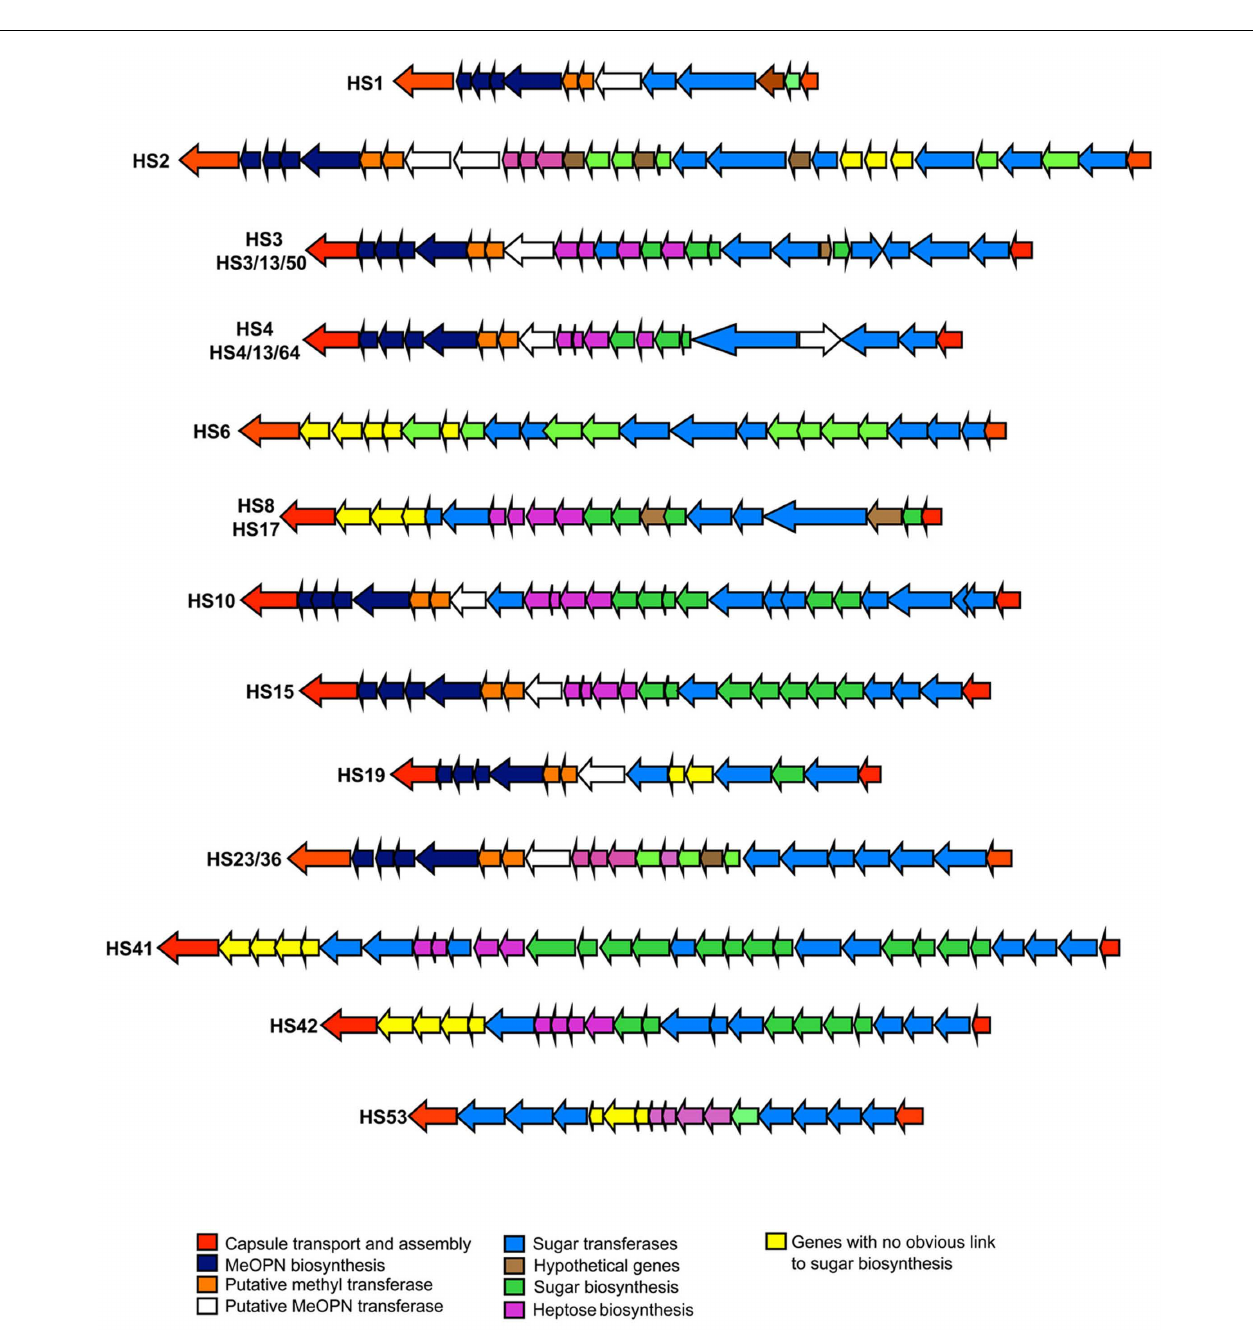
FIGURE 3 | Schematic of variable region 2 CPS loci from sequenced representative Penner serotype loci. The function or putative function of genes is color-coded, as indicated.